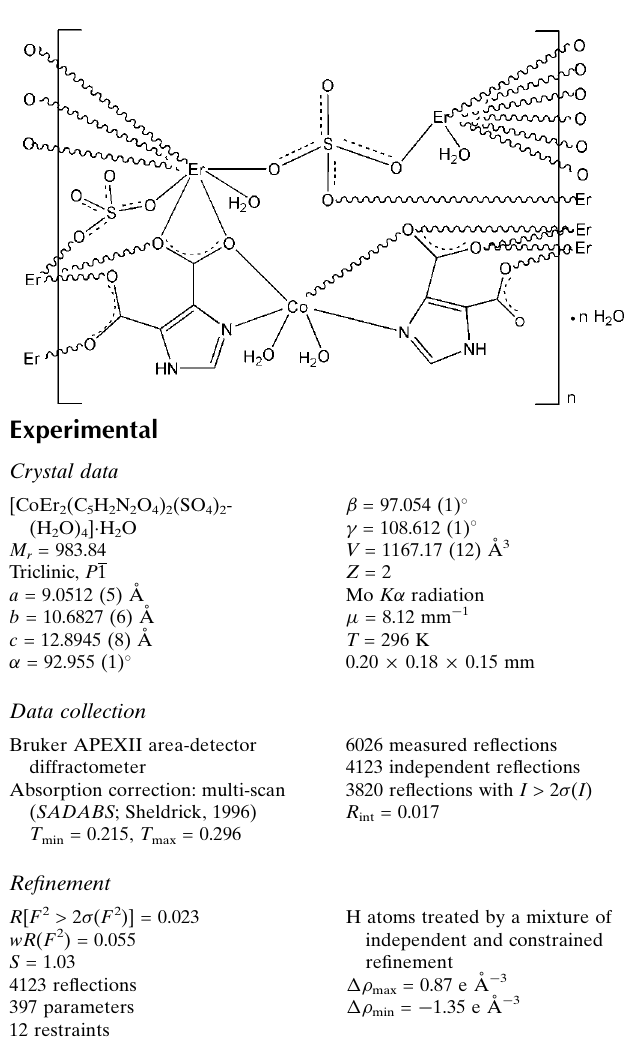
6026 measured reflections 4123 independent reflections 3820 reflections with I > 2 (cid:2) ( I ) R H atoms treated by a mixture of independent and constrained refinement (cid:2) (cid:7) max = 0.87 e A˚ (cid:3) 3